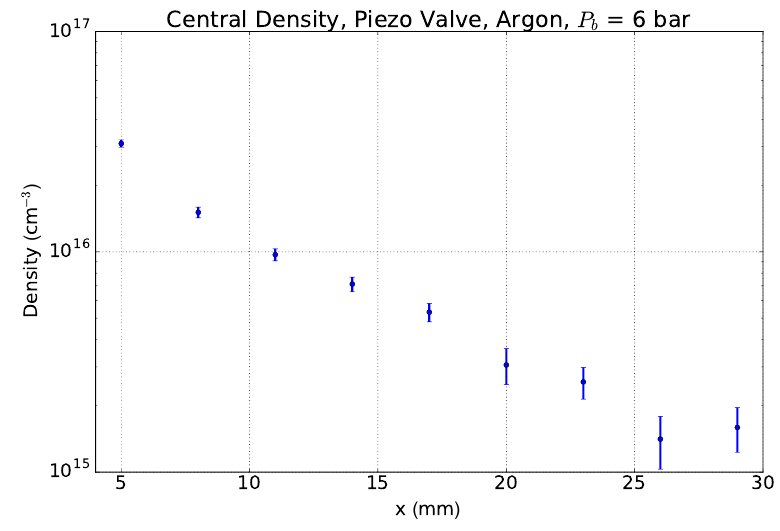
Figure 14. The central density in the gas jet reduces by a factor of 20 after expanding 25